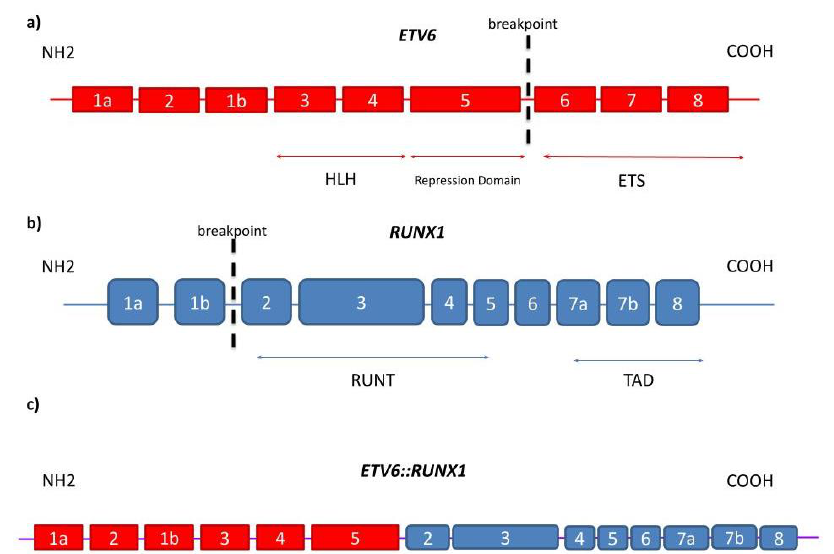
Figure 3. ( a ) On ETV6 gene, which consists of nine exons, the translocation occurs between exon 5 and exon 6; ( b ) On RUNX1 gene, the breakpoint is located between exon 1b and exon 2 out of 10 exons in total; ( c ) the fusion results in formation of ETV6::RUNX1 translocation which is transcribed into ETV6::RUNX1 fusion